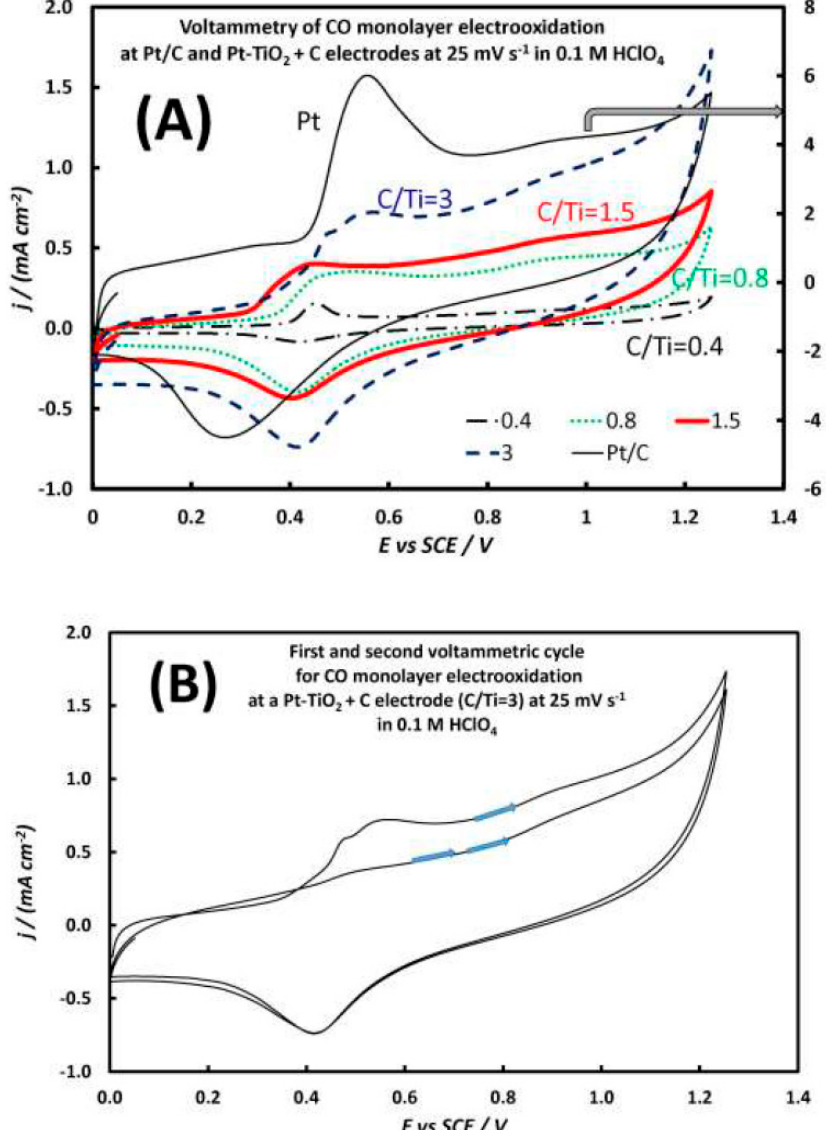
Figure 3. ( A ) Cyclic Voltamograms, CVs, first cycle, recorded in 0.1 M HClO 4 solutions at 25 mV s −